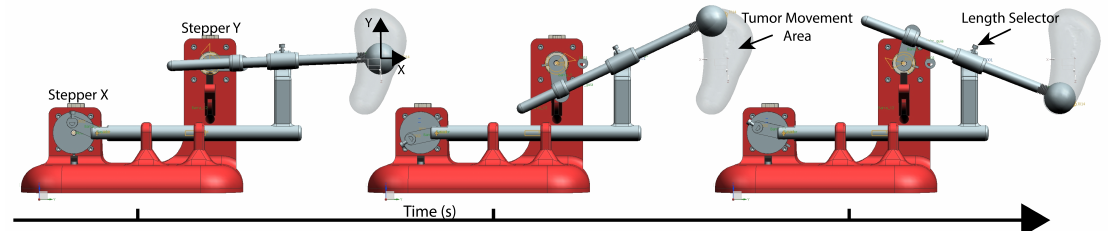
Figure 4. Virtual simulation of the desired area to cover with the LTMS in order to validate the viability of the system design.